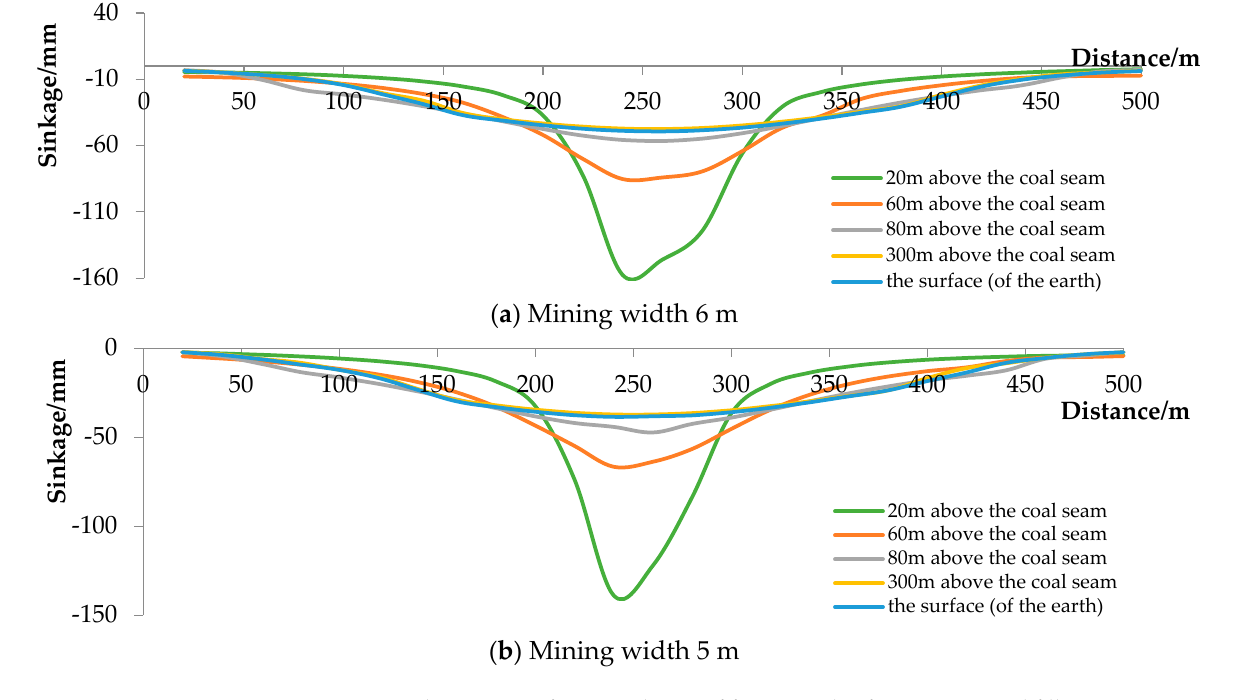
Figure 21. Sinking curve after completion of four rounds of excavation and filling. Table 9. Maximum overburden subsidence for different mining width conditions. Rock